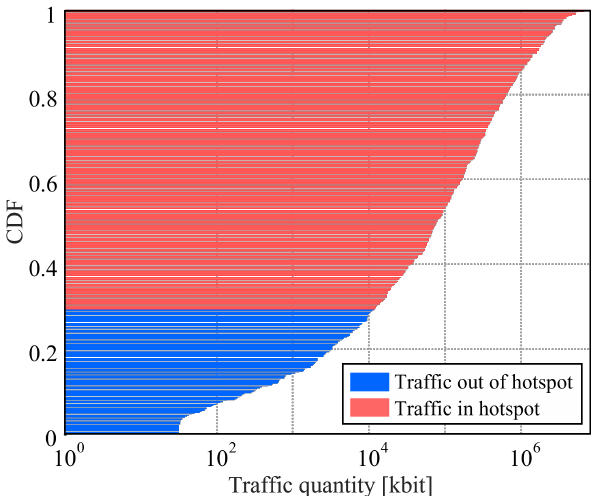
Figure 4. The CDF of the traffic amount to